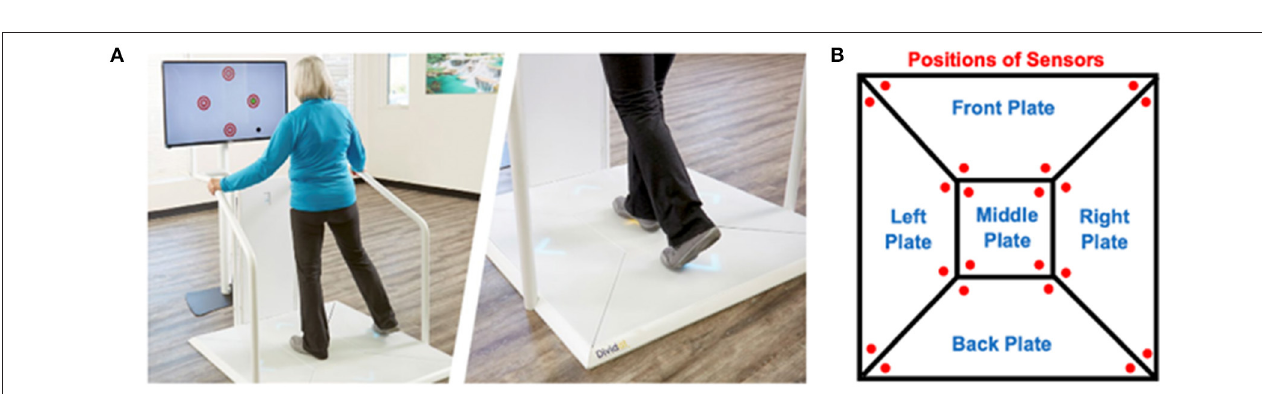
FIGURE 2 | (A) A participant training on the Dividat SENSO (Dividat AG, Schindellegi, Switzerland). (B) Top view of the pressure-sensitive plate of the Dividat SENSO, showing the position of the sensors.